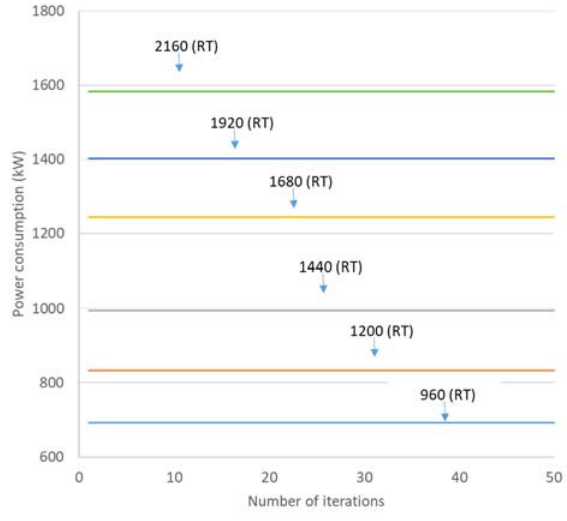
Figure 6. Power consumptions of chillers in Case 3 operated by TPSO algorithm.